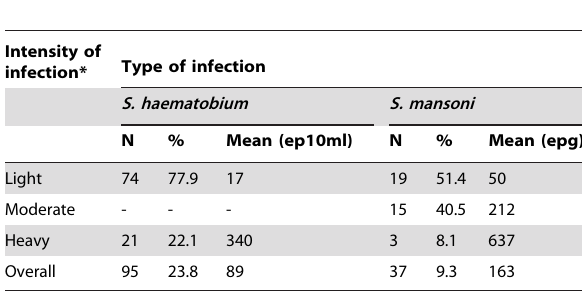
Table 2. Prevalence and intensity of schistosomiasis among Yemeni children who participated in this study